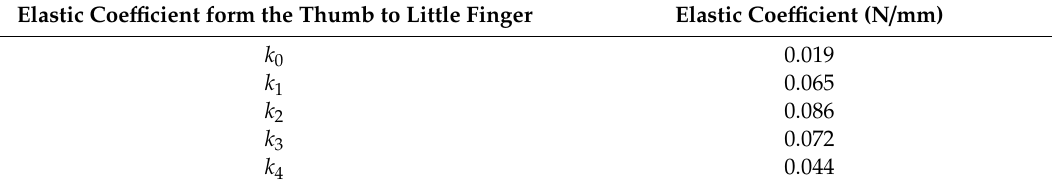
Table A3. Elastic coe ffi cient of each tendon.